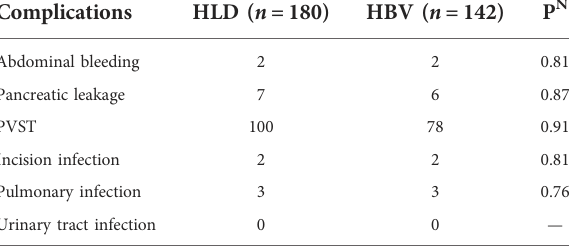
P N refers to the postoperative time of main and in vivo effects in the group× the fi xed time level of the group, and the differences in each level of individual effects in the group. HLD, hepatolenticular degeneration; HBV, viral hepatitis B; BMI, body mass index; PVST, portal vein thrombosis